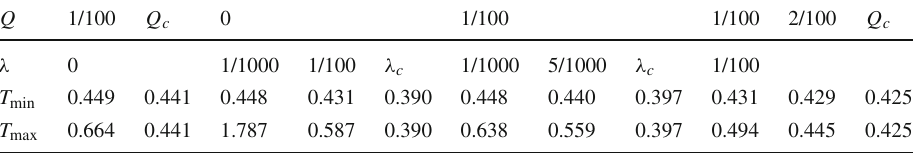
Fig. 3 Global behavior of ˜ η/ s as a function of the temperature for charged GB BHs. Left panel : GB BHs with fixed charge Q = 1 / 100, and selected values of GB constant λ = 1 / 1000 , 5 / 1000 , ∼ 0 . 25 , 5 / 100. The value of ˜ η/ s is rescaled by a factor 1 − 4 λ ; in this way the large T behavior of 4 π ˜ η/ s which for GB gravity is Table 1 Critical temperatures for selected values of λ and Q below and at the critical